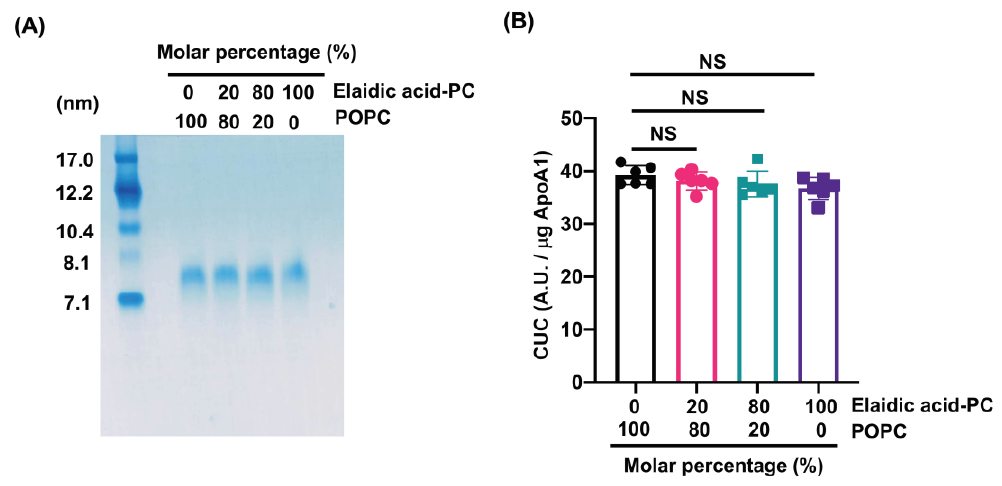
Figure 2. Elaidic acid-PC contents in rHDL do not affect particle size and CUC. ( A ) rHDL containing different POPC and elaidic acid-PC molar percentages was prepared and native polyacrylamide gel electrophoresis (PAGE) analysis was performed in a 4–20% polyacrylamide gel to assess the particle size. Standard proteins of known hydrodynamic diameters were used for this analysis. Samples (1.0 μ g proteins) were separated by non-denaturing gel electrophoresis and stained with Coomassie Brilliant Blue. ( B ) rHDL containing different POPC and elaidic acid-PC molar percentages was prepared and CUC assay was performed. Values are expressed as the mean ± SD ( n = 6). CUC, cholesterol uptake capacity; A.U., arbitrary units; NS, not significant. Data analyzed by one-way ANOVA with Dunnett’s multiple comparisons test.